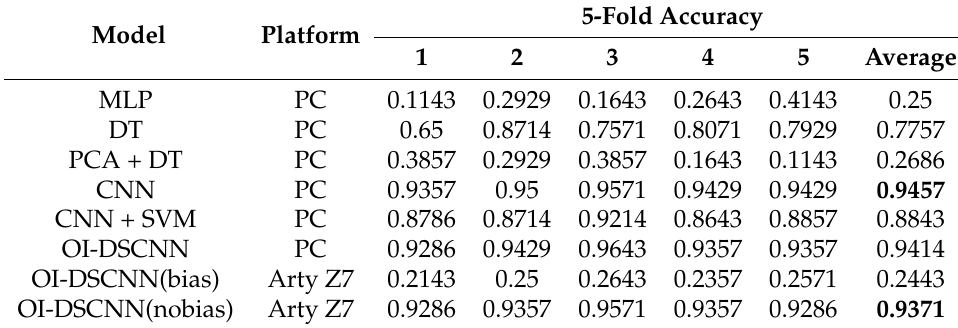
Table 6. Model performance comparison.